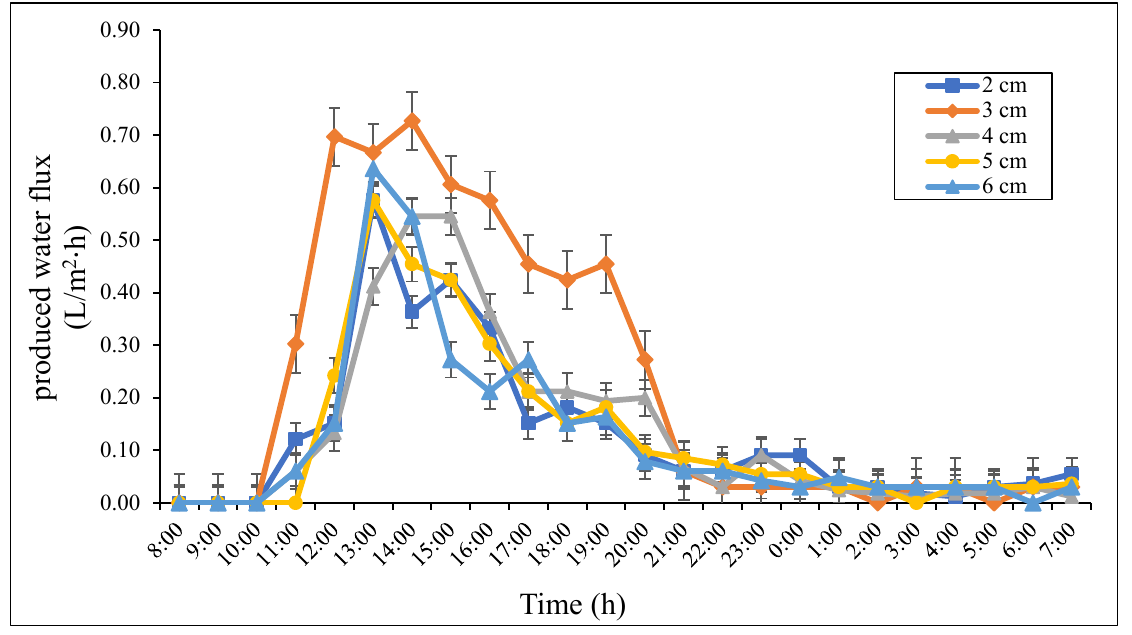
Figure 8. Effect of the pool depth on the water production rate.